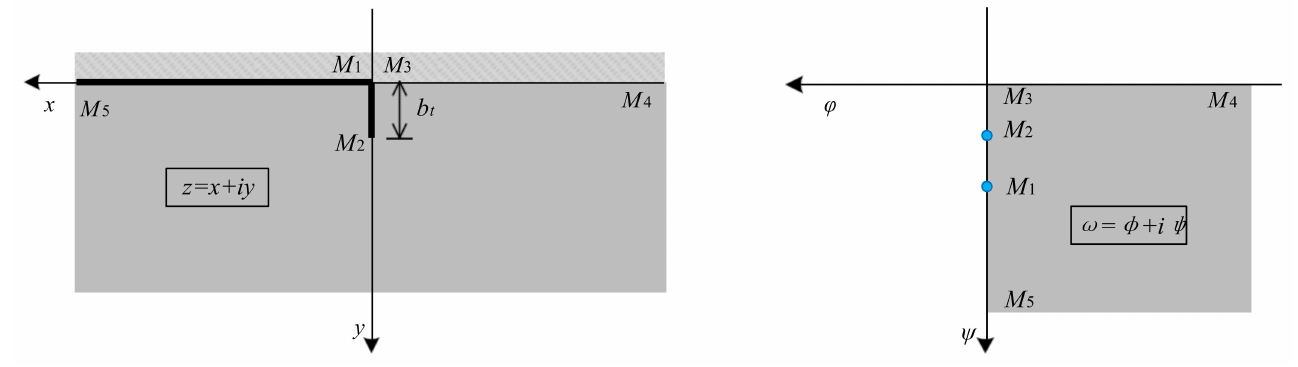
Figure 5. Conformal mapping schemes for the channel tip